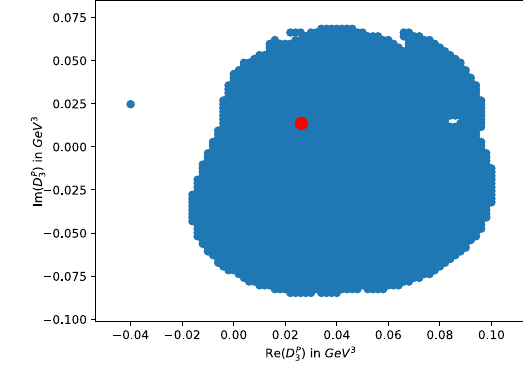
Fig. 4 SU ( 3 ) fit, part3. Amplitudes carry units of GeV